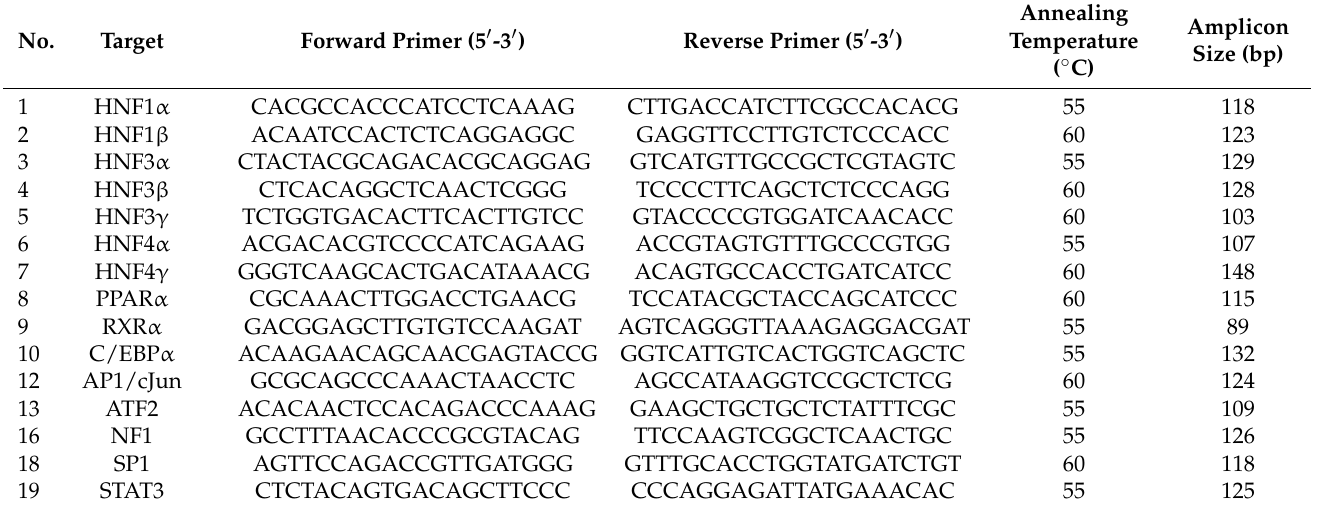
Table 2. Primers used for transcription factors